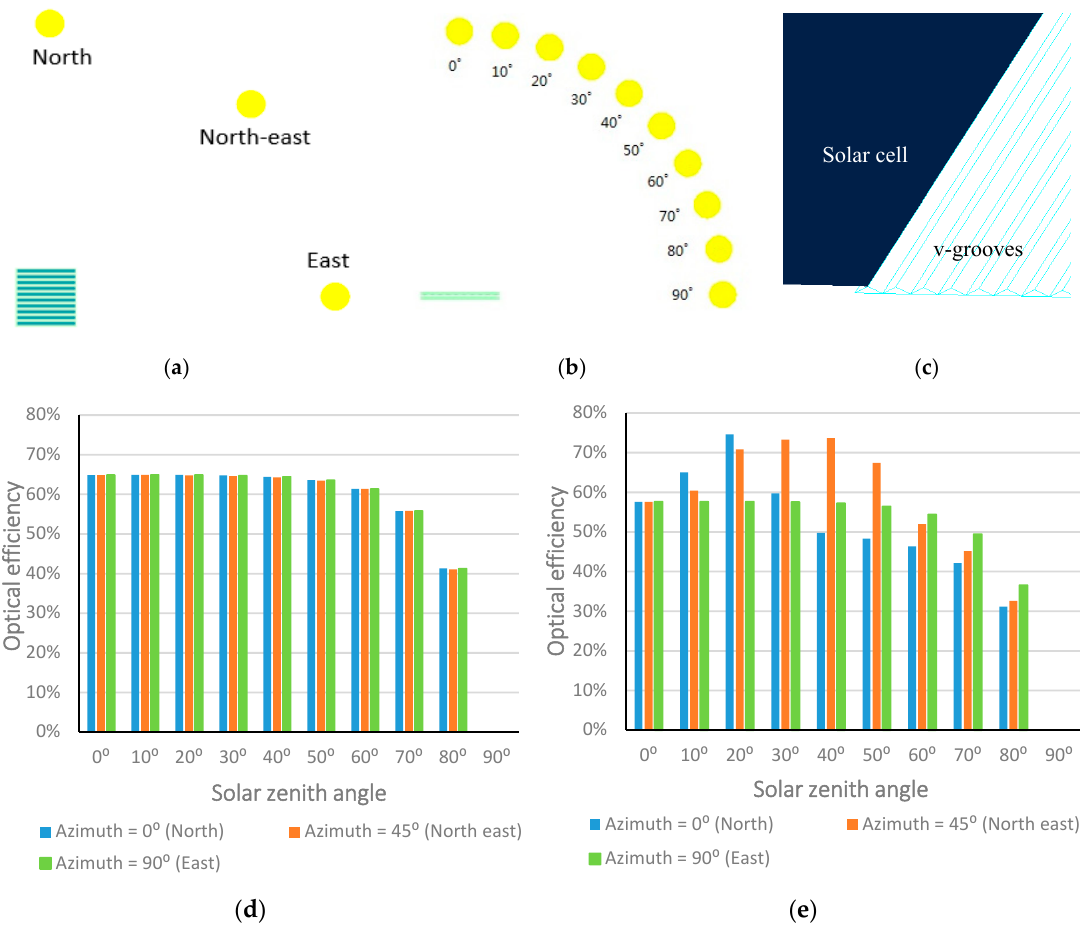
Figure 8. Raytracing simulation at ( a ) three different solar azimuths and ( b ) at the solar zenith angles from 0 to 90°; ( c ) diagram of the module with v-grooves; ( d ) optical efficiencies of the Lambertian reflector based module at different solar zenith angles and solar azimuths; and ( e ) optical efficiencies of the v-groove reflector based module at different solar zenith angles and solar azimuths.